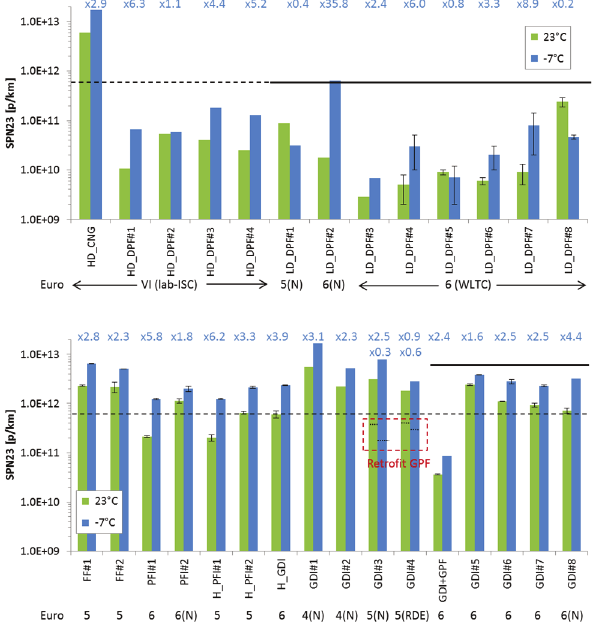
Fig. 6. Emissions from various vehicles at 23°C and –7°C. Upper panel: Heavy-duty (HD) vehicles and light-duty (LD) diesel vehicles. Lower panel: Gasoline light-duty vehicles. Data from [22, 32–37]. The solid line show the applicable limits of 6×10 11 p/km for diesel light-duty vehicles and 6×10 12 p/km for GDIs. Dashed lines are aid to the eye. The SPN limit applies only to heavy-duty engines (not vehicles) and is expressed in p/kWh. “N” for NEDC. Euro level is shown at the lower part of the fig- ures. Ratio of –7°C to 23°C SPN23 emissions is given at the upper part of